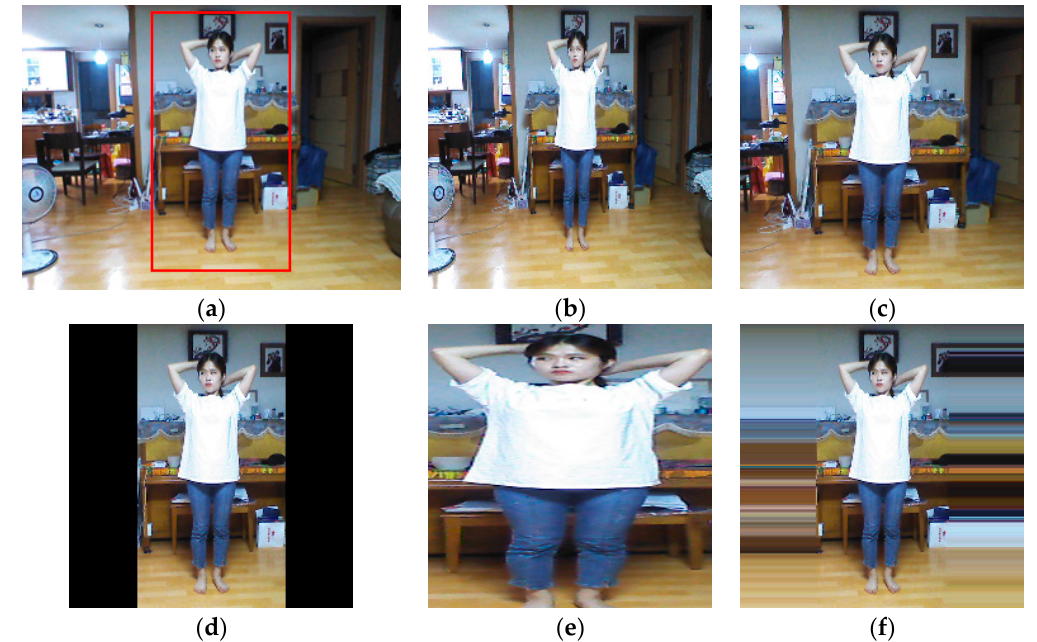
Figure 11. Examples of five types of original and preprocessed images: ( a ) original image; ( b ) type 0; ( c ) type 1; ( d ) type 2; ( e ) type 4; ( f ) type 5.